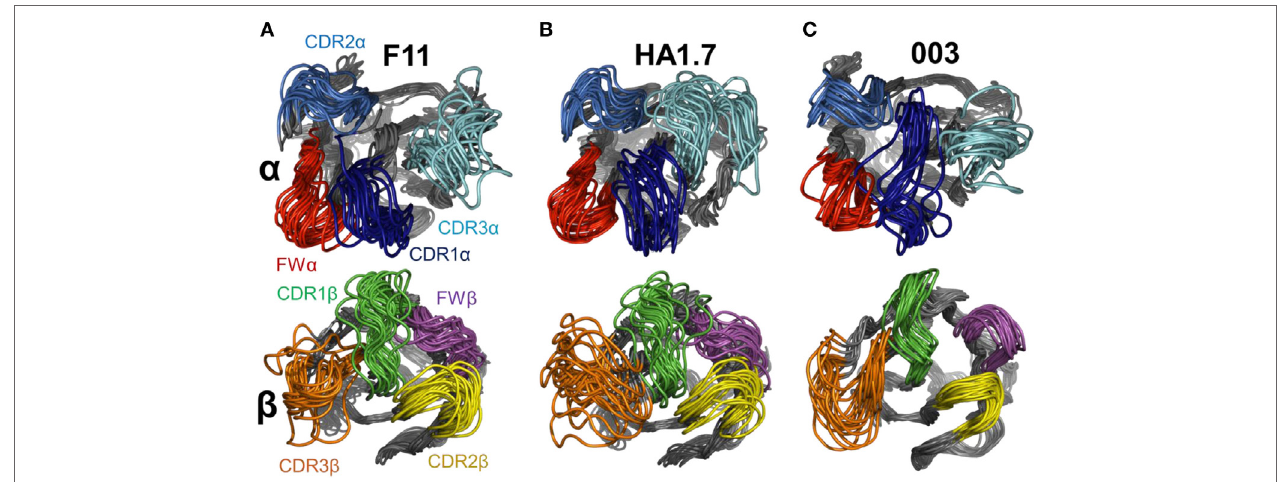
FigUre 5 | Flexible variations in the T cell receptor (TCR) complementarity determining region (CDR) loops using FRODA simulations. To isolate the loop motions, an alignment on the N -terminal domain for each TCR was performed (residues 6–110) to allow visualization of the loop structural variations relative to a stable base of comparison. Each panel shows a set of 20 structural variants aligned onto the initial crystal structure. Top panel TCR α CDR loops, bottom panel TCR β CDR loops. For each normal mode, we selected the variants representing the natural limit of flexible motion parallel and antiparallel to the mode direction. The four loops are colored as follows: CDR1 α in dark blue, CDR2 α in blue, CDR3 α in cyan, FW α in red, CDR1 β in green, CDR2 β in yellow, CDR3 β in orange, and FW β in purple. (a) F11 TCR. (b) HA1.7 TCR. (c) 003